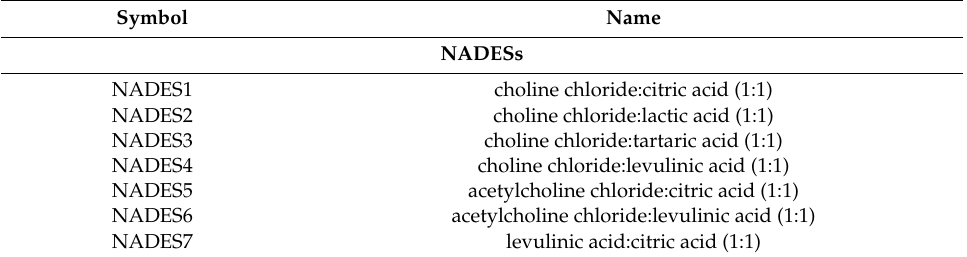
Table 4. List of NADES and ILs used for